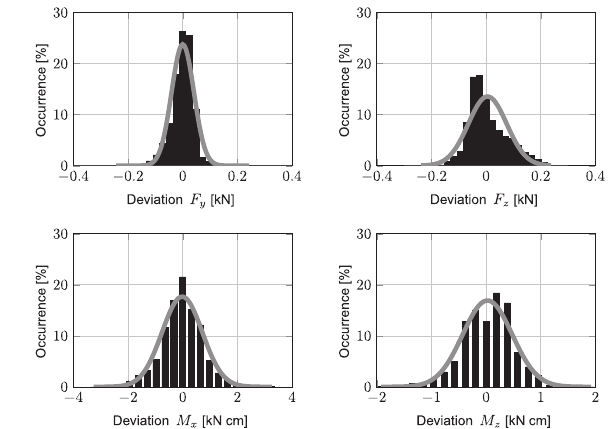
Figure 10. Histogram of the deviations.